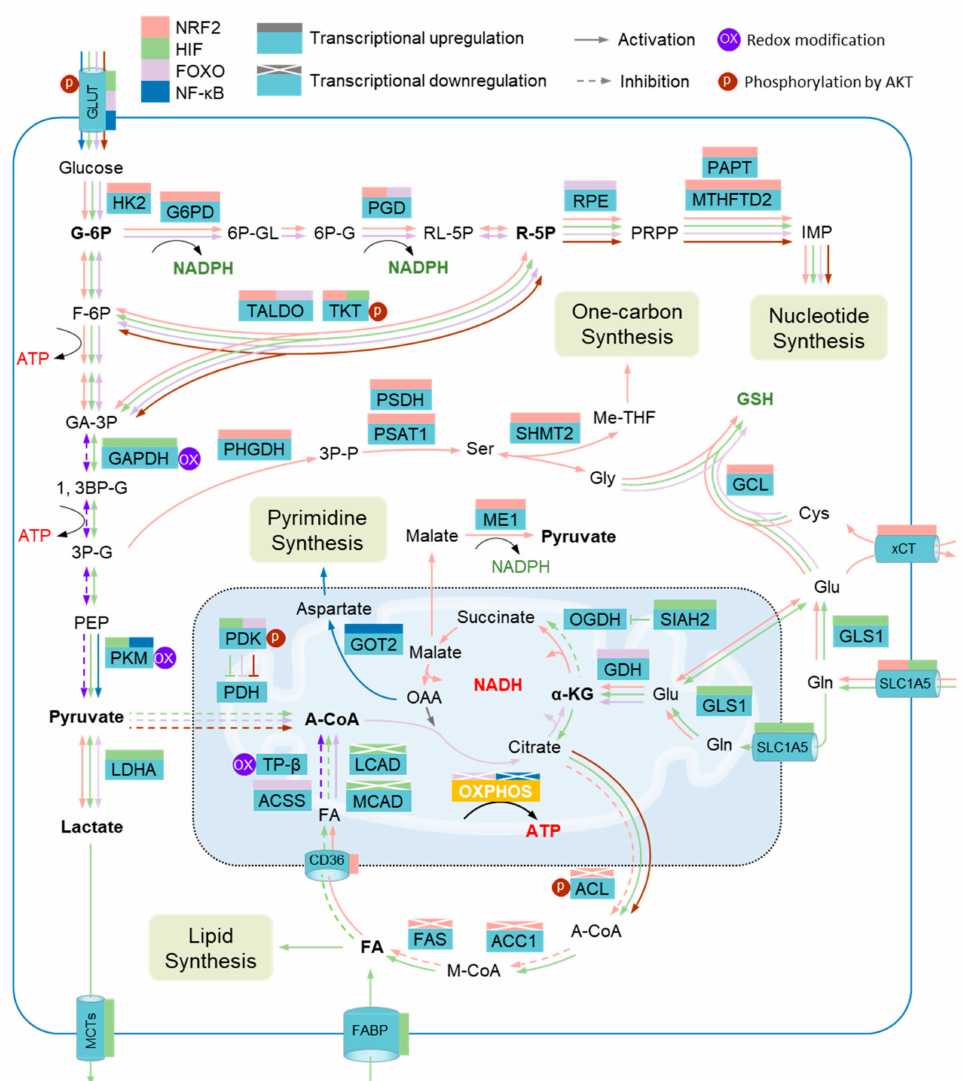
Figure 3. Metabolic adaptation to oxidative stress and metabolic impairment. Several metabolic enzymes are vulnerable to elevated reactive oxygen species (ROS) levels, including glyceraldehyde- 3-phosphate dehydrogenase (GAPDH), pyruvate kinase M2 isoform (PKM2), and mitochondrial trifunc-tional protein subunit β (TP β ). Metabolic adaptation during oxidative stress depends on the collaboration of several metabolic modulators that serve to promote metabolic reprograming through regulating the expression of metabolic enzymes. The transcriptions of a host of enzymes in the pentose phosphate pathway (PPP), the serine (Ser)-one carbon pathway, the glutathione pathway (GSH), and glutaminolysis are driven by nuclear factor erythroid 2-related factor 2 (NRF2), including hexokinase 2 (HK2), glucose-6-phosphate dehydrogenase (G6PD), phosphogluconate dehydro- genase (PGD), transaldolase (TALDO), transketolase (TKT), putrescine aminopropyltransferase (PAPT), methylenetetrahydrofolate dehydrogenase 2 (MTHFD2), phosphoglycerate dehydrogenase (PHGDH), phosphoserine phosphatase (PSDH), phosphoserine aminotransferase 1 (PSAT1), serine hydroxymethyltransferase 2 (SHMT2), glutamate-cysteine ligase (GCL), cystine/glutamate trans- porter (xCT), solute carrier family 1 member 5 (GLC1A5), and malic enzyme 1 (ME1), while several other enzymes involved in the de novo synthesis of fatty acids are transcriptionally inhibited by NRF2, such as acetyl-CoA carboxylase 1 (ACC1), ATP-citrate lyase (ACL), and fatty acid synthase (FAS). Hypoxia-inducible factor (HIF) members promote the expression of enzymes involved in anaerobic glycolysis, de novo synthesis of fatty acids, and glutaminolysis, including glucose trans- porters (GLUTs), GAPDH, PKM, siah E3 ubiquitin protein ligase 2 (SIAH2), pyruvate